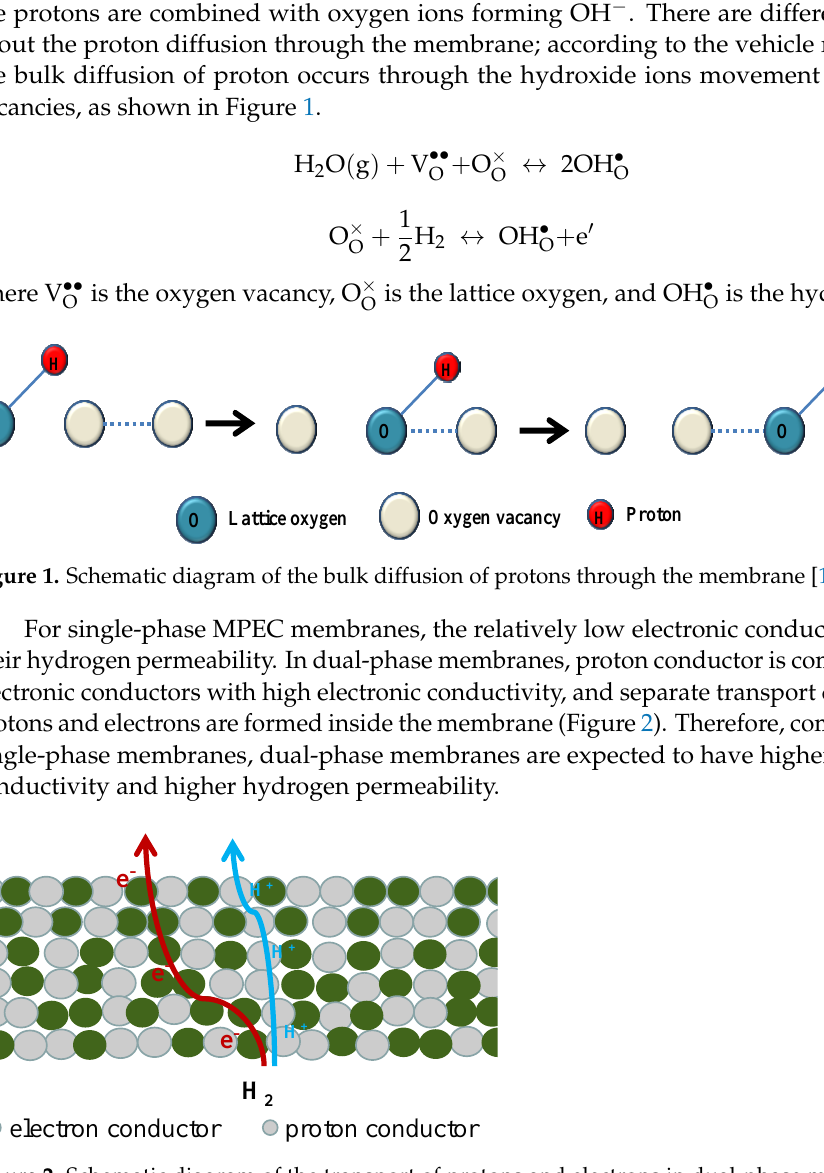
Figure 2. Schematic diagram of the transport of protons and electrons in dual-phase membranes.